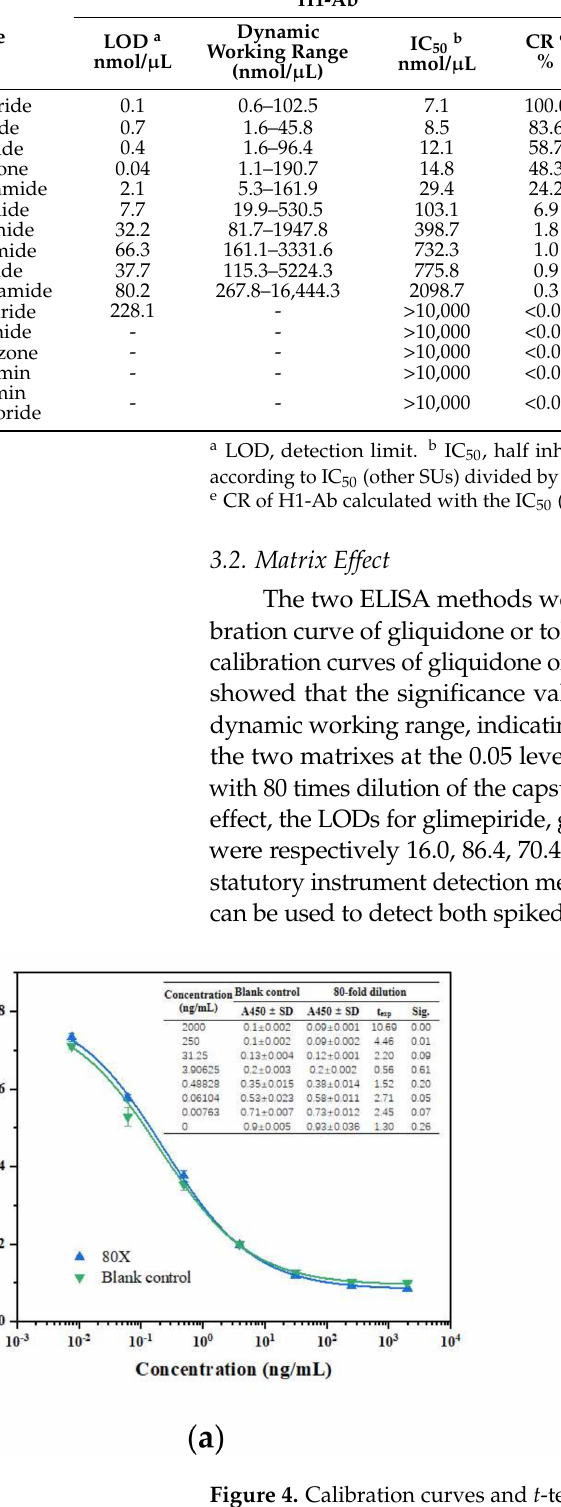
Figure 4. Calibration curves and t -test results of ic-ELISA in PBST and dilution 80 times ( a ) Glipizide as the drug for H1-Ab/Hapten 3-OVA ic-ELISA; ( b ) Tolbutamide as the drug for H2-Ab/Hapten 4-OVA ic-ELISA; The texp and Sig. determined by the t test ( p =